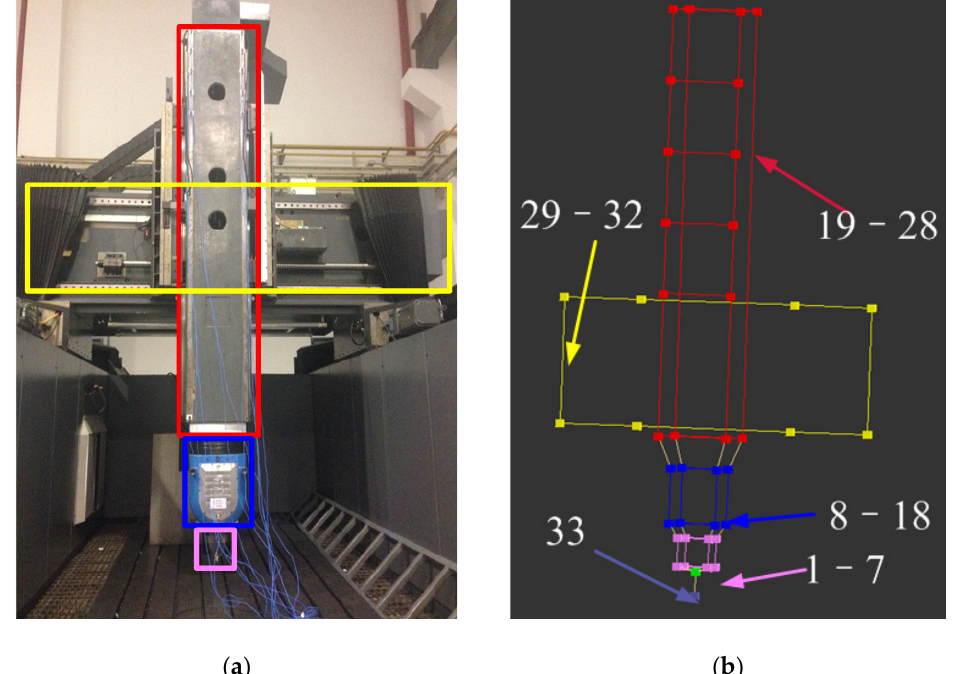
Figure 4. Layout of measuring points in percussion test: ( a ) five-axis gantry machining center; ( b ) layout of measuring points.